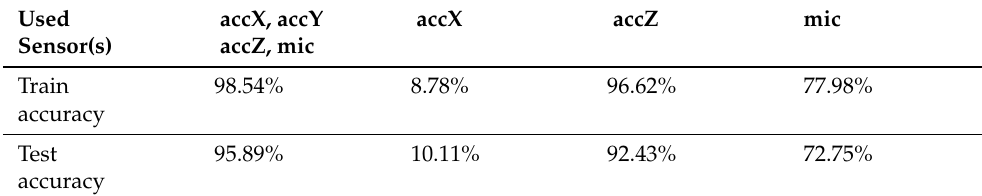
Table 3. Accuracy of the conventional LSTM model (two